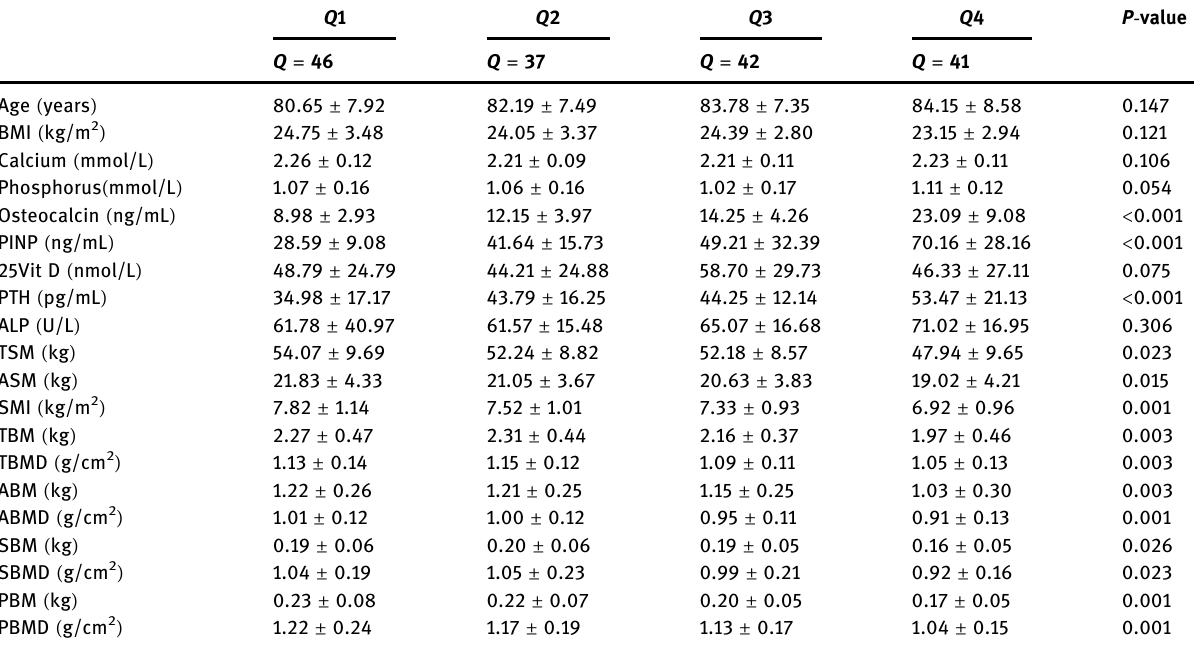
Table 3: Characteristics of the subjects according to the quartiles of serum β - CTX